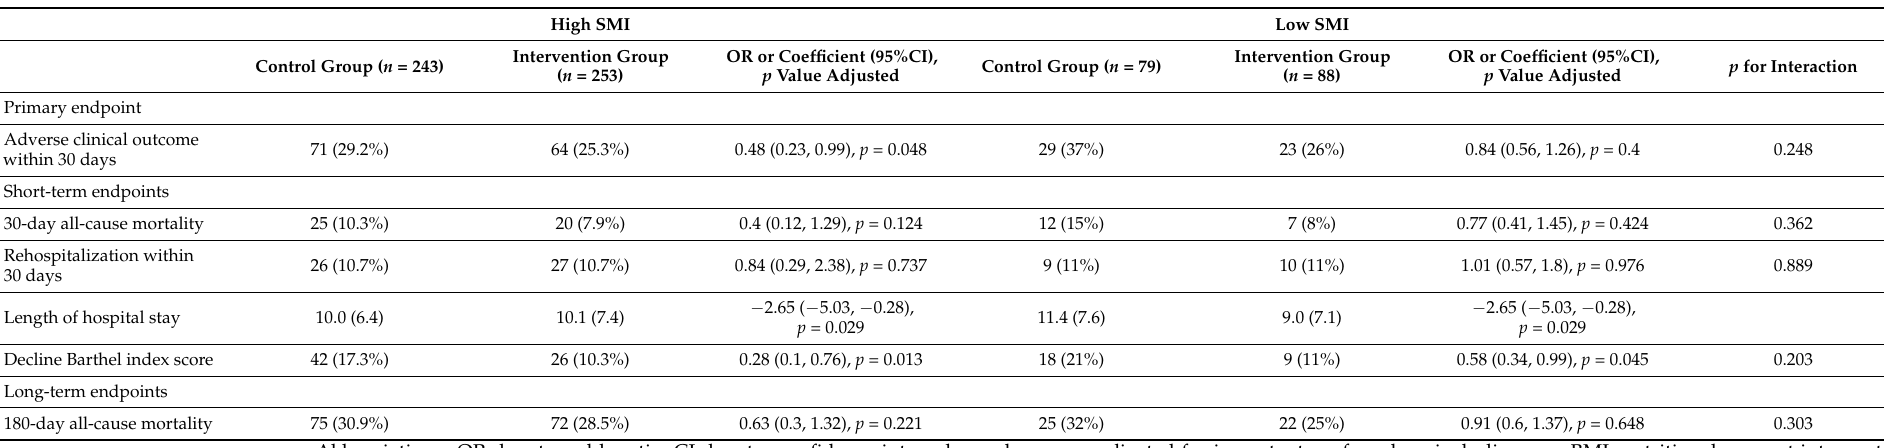
Table 4. Effects of nutritional support on clinical outcomes of patients in the lowest and in the other three quartiles of SMI at level T12. High SMI Low SMI Control Group ( n = 243) Intervention Group ( n = 253) OR or Coefficient (95%CI), p Value Adjusted Control Group ( n = 79) Intervention Group ( n = 88) OR or Coefficient (95%CI), p Value